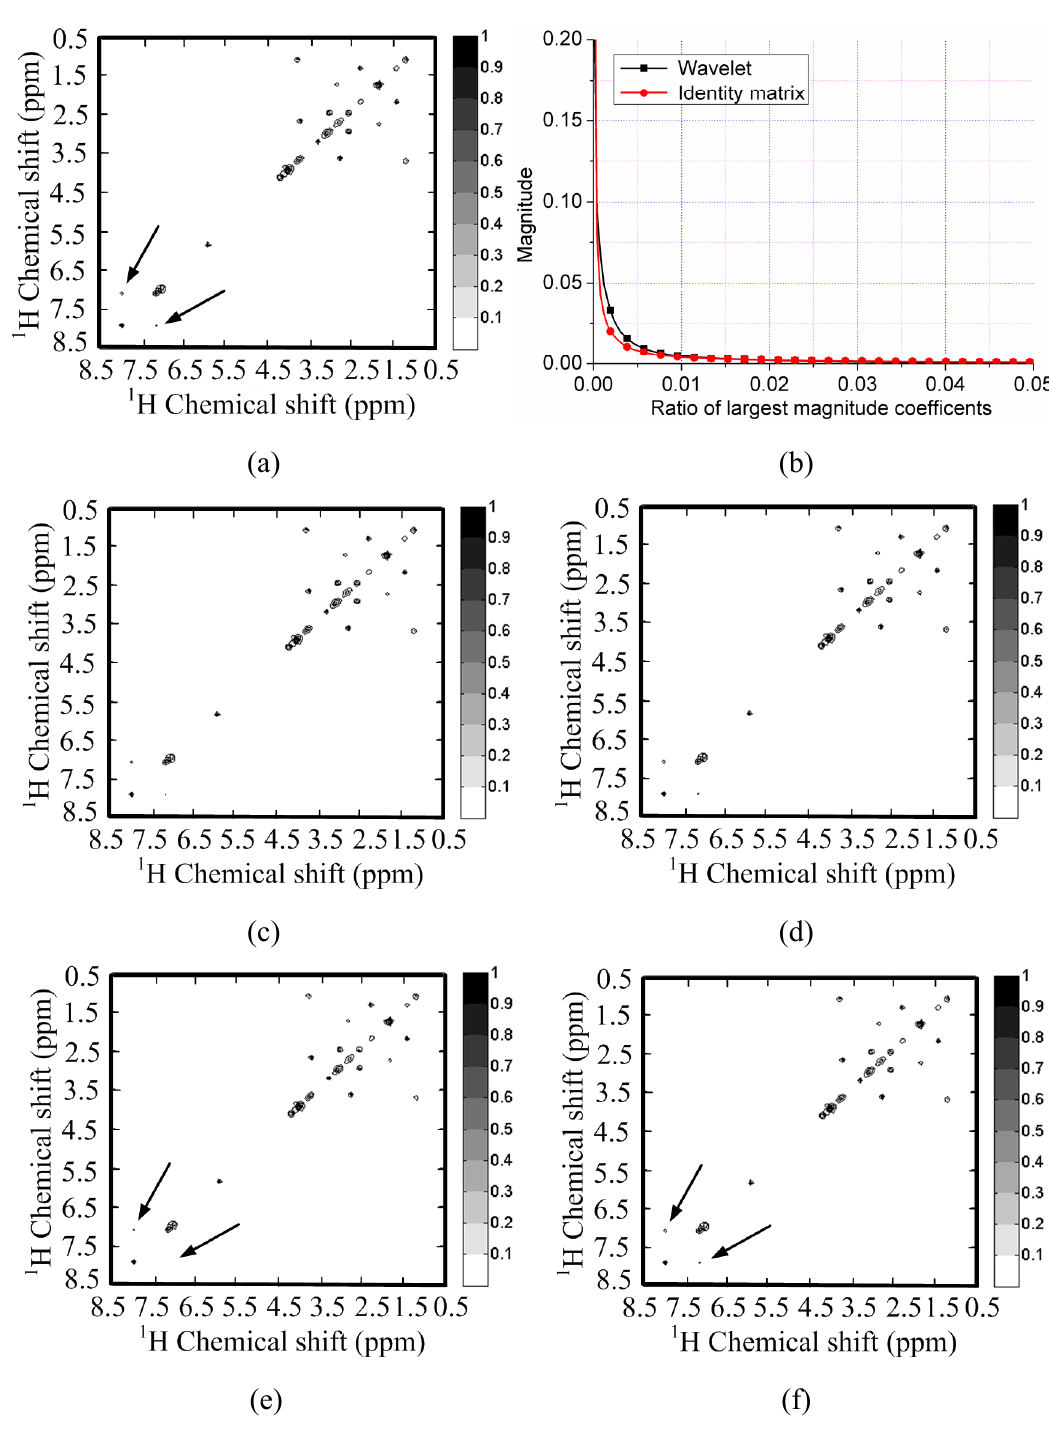
Figure 4. Sparsity of a 1 H- 1 H COSY spectrum and its wavelet (symmlet wavelet with four decomposition levels and eight vanishing moments) representation. ( a ) The fully sampled NMR spectrum; ( b ) decay of real part of spectrum and its wavelet coefficients; ( c , e ) reconstructed spectra from 3% and 1% largest coefficients in wavelet domain; ( d , f ) reconstructed spectra from 3% and 1% largest coefficients in identity matrix domain. Note: the wavelet fails to represent peaks marked with arrows in (e) and these peaks are successfully represented in